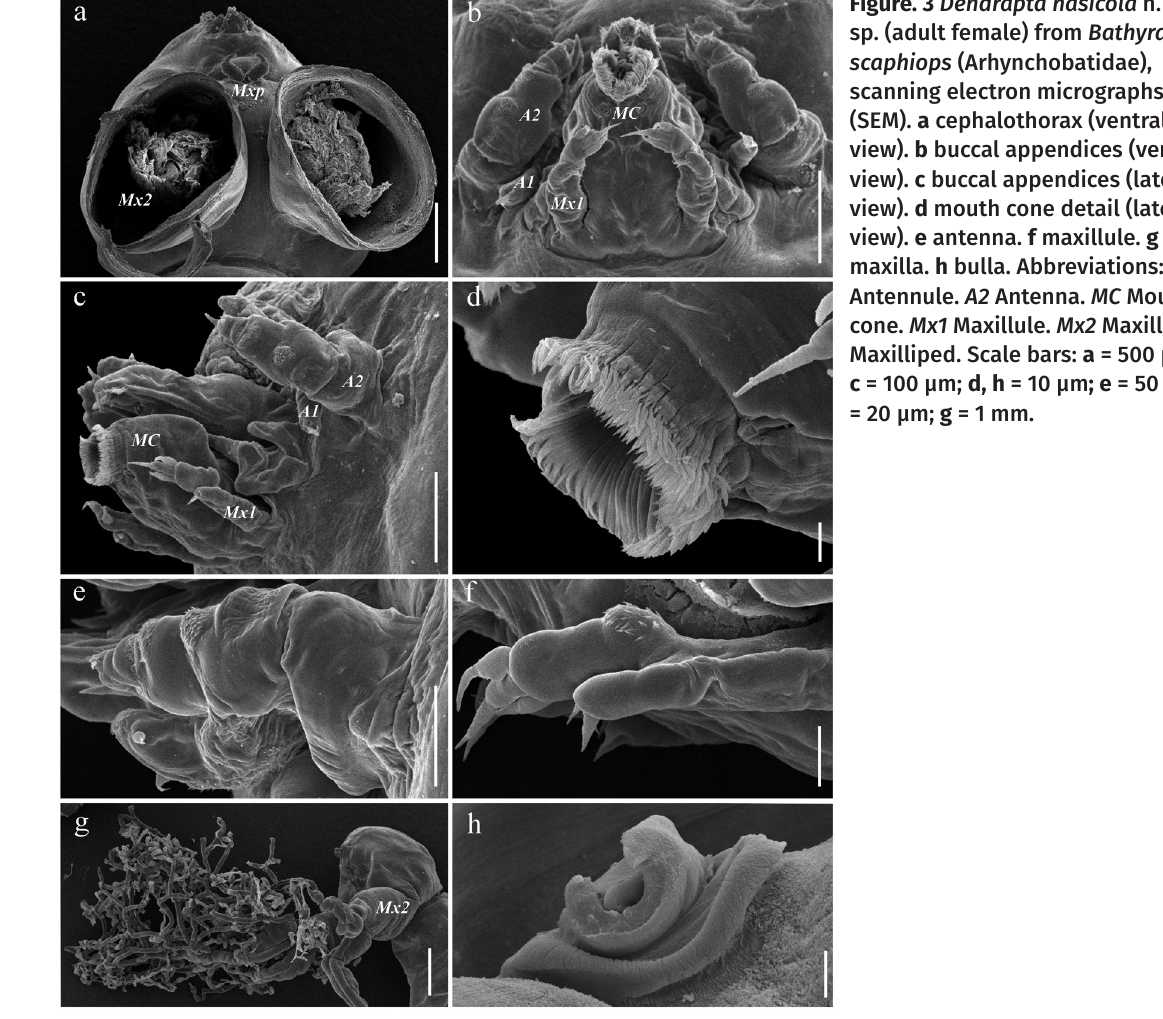
Figure. 3 Dendrapta nasicola